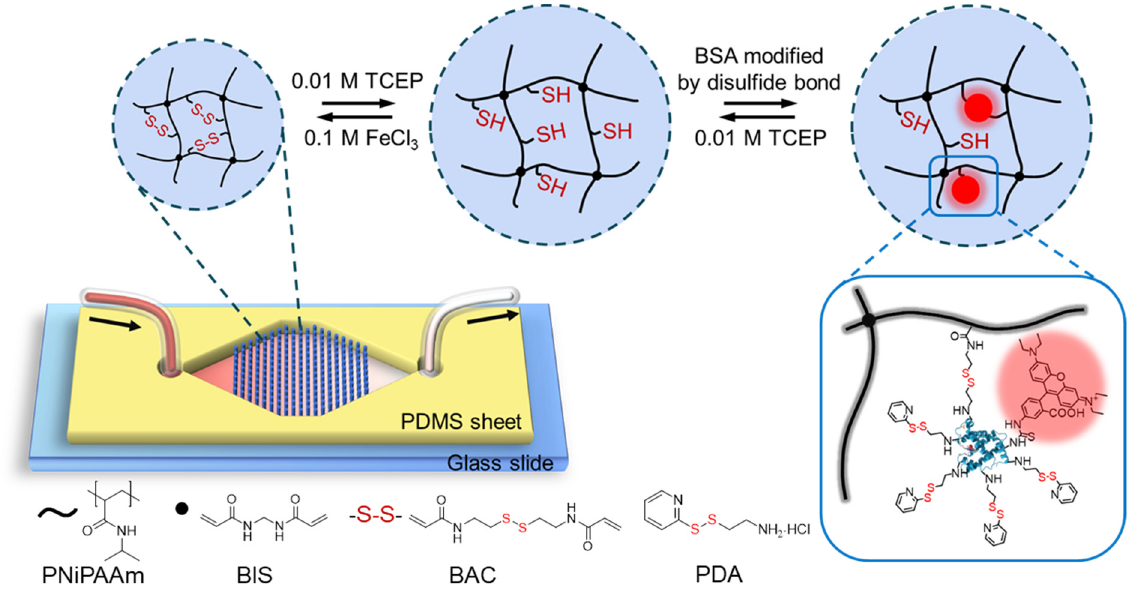
Figure 1. Schematic drawing of the microfluidic chip design and the reversible redox-responsive property of double cross-linked PNiPAAm hydrogel dots permanently cross-linked by BIS and reversibly cross-linked by the disulfide bonds of BAC. By the cleavage and re-formation of disulfide bonds in hydrogel dots, the capture and release of modified BSA can be achieved. BSA was modified with rhodamine B and PDA (bottom right), which introduced the disulfide bonds.